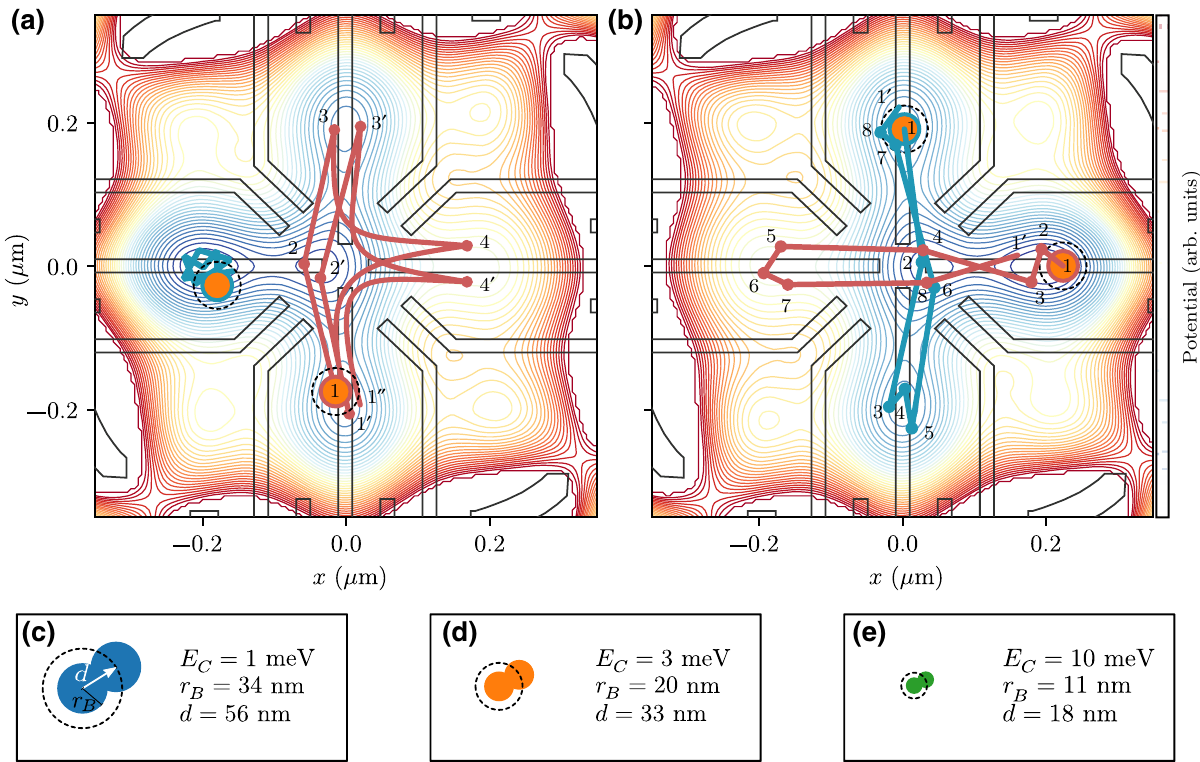
FIG. 11. Electrostatic potential simulations. (a),(b) Electrostatic potential simulations performed with gate-voltage configurations corresponding to the confinement of two electrons (a) in L - B and (b) in T - R . Hypothetical electron trajectories (dots) are overlapped for the two displacement patterns considered. The solid lines are guides for the eye. (a) A single electron is periodically displaced between dots ( B , C , T , and R ), while the other electron remains in the L dot. Four dot configurations are explored, but the dot positions evolve at each period (two periods are drawn, e.g., 1 → 1 (cid:6) → 1 (cid:6)(cid:6) ). (b) Two electrons are displaced, one between ( L , C , R ) and the other between ( T , C , B ). Eight dot configurations are explored and, here again, the dot positions evolve at each displacement period (a single period is drawn, e.g., 1 → 1 (cid:6) ). The electrostatic potential simulations are performed by solving the Laplace equation [35]. The orange circles have a radius of 20 nm, corresponding to the Bohr radius of an electron with a charging energy E C of 3 meV. The dashed circles have a radius of 33 nm, a value computed to reach a remanence R = 0.5. (c)–(e) Schematic representations of the Bohr radii and corresponding dot displacements to reach a remanence R = 0.5 for different electron charging